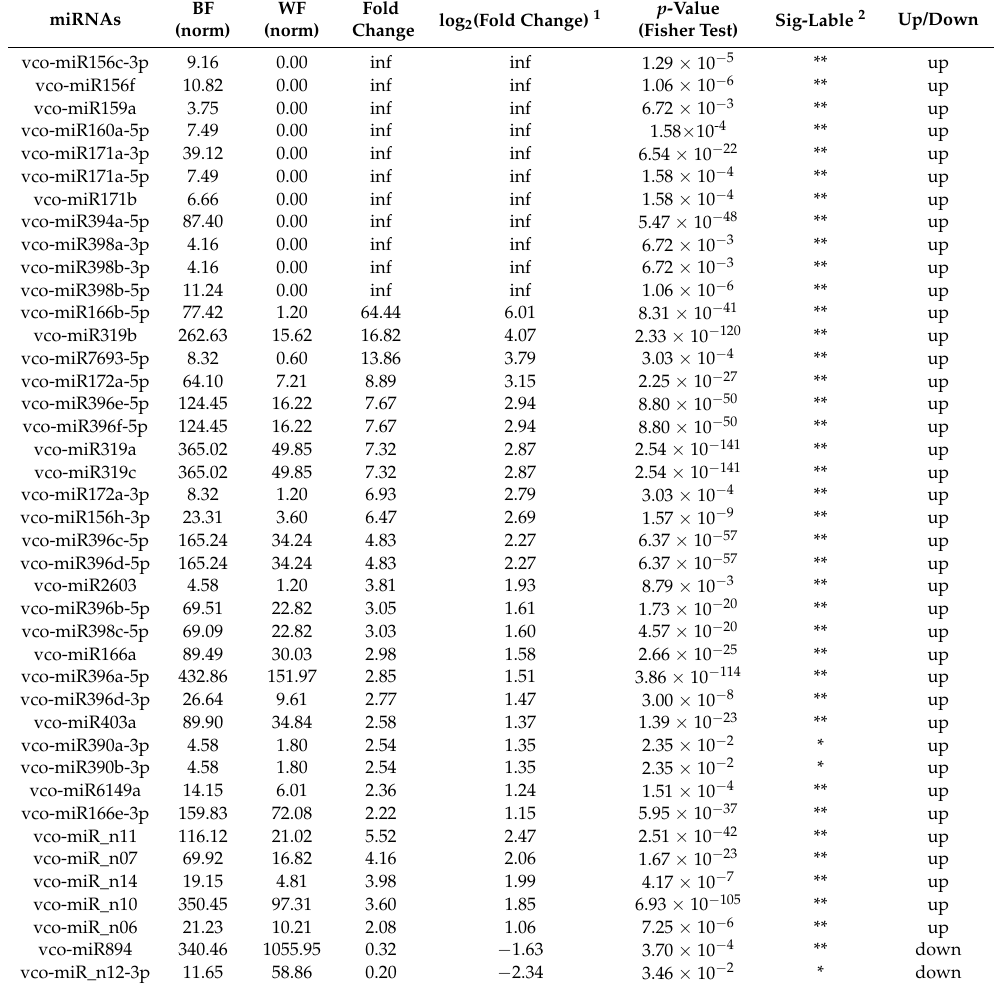
Table 2. Differentially expressed miRNAs between WF (white fruit) and BF (blue fruit) libraries in blueberry. BF WF Fold miRNAs log 2 (Fold Change) 1 (norm) (norm) Change